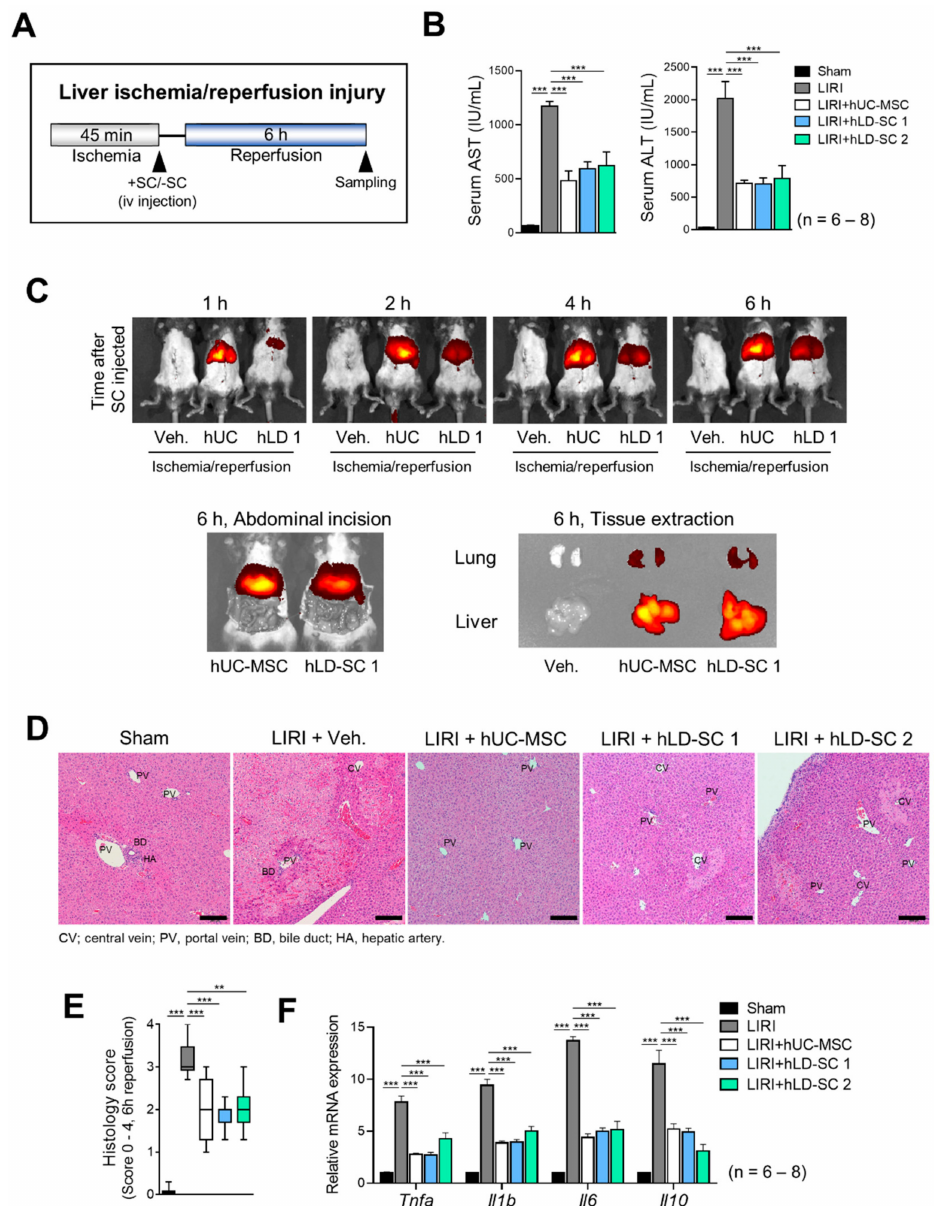
Figure 5. Tra ffi cking of hUC-MSCs and hLD-SCs in liver ischemia-reperfusion injury (LIRI) mice. ( A ) Schematic diagram of LIRI in C57BL / 6 mice. ( B ) Serum levels of aspartate transaminase (AST) and alanine transaminase (ALT). P -values < 0.05 were considered significant. n = 6 for sham; n = 8